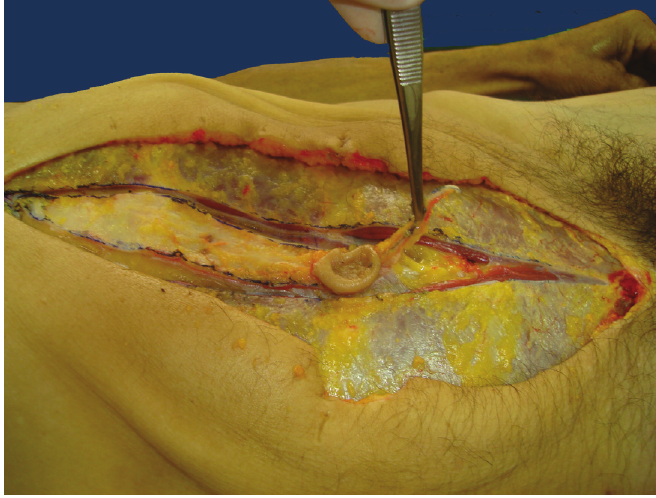
FIGURE 1 – Creation of the musculoaponeurotic defect in the cadaver. Study points were marked on the anterior layer of the rectus abdominis muscle at the desired measurement locations, without muscle or aponeurosis displacement. Reference points for tensile measurements were marked on the anterior